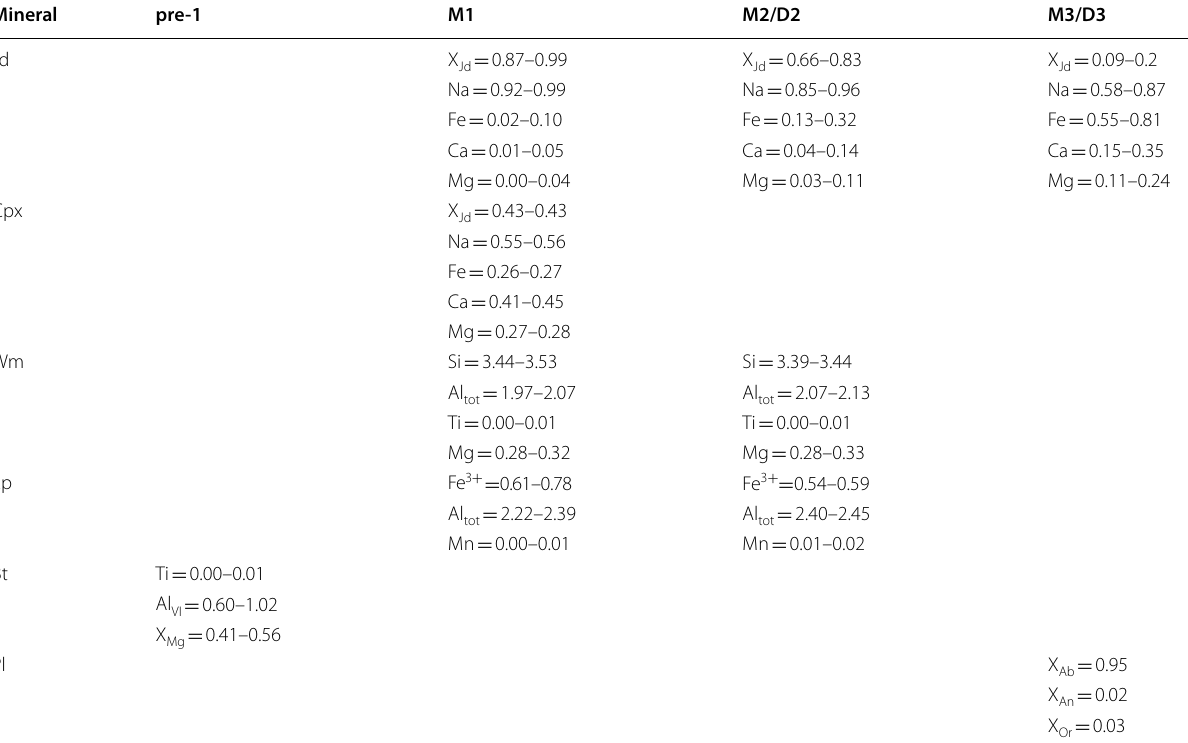
Table 3 Intervals of compositional variations in minerals marking different metamorphic stages of garnet-free gneiss Mineral